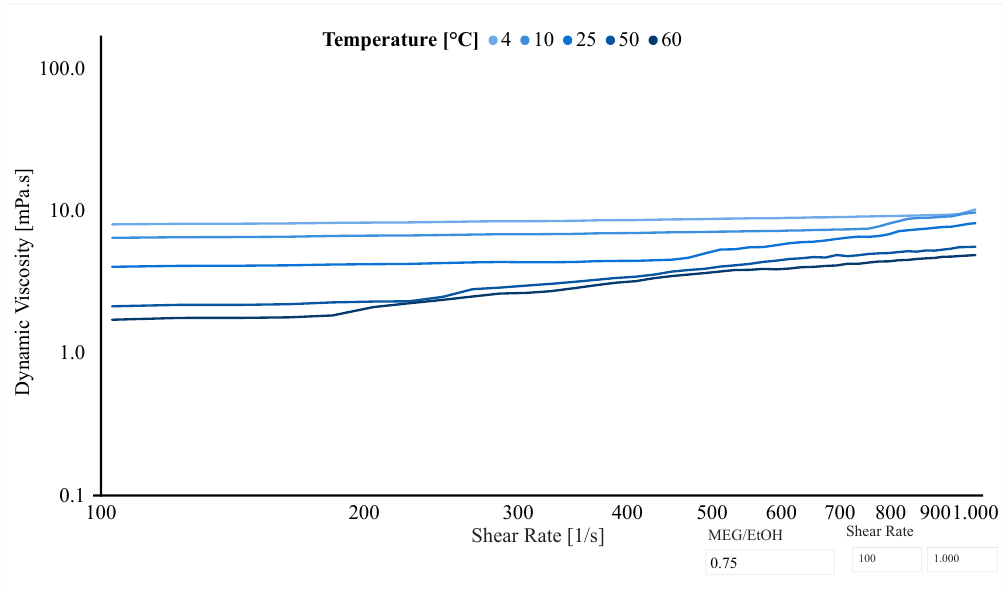
Figure 6. Dynamic viscosity of the MEG/EtOH mixture as function of shear rate for different temperatures, 75%MEG/EtOH